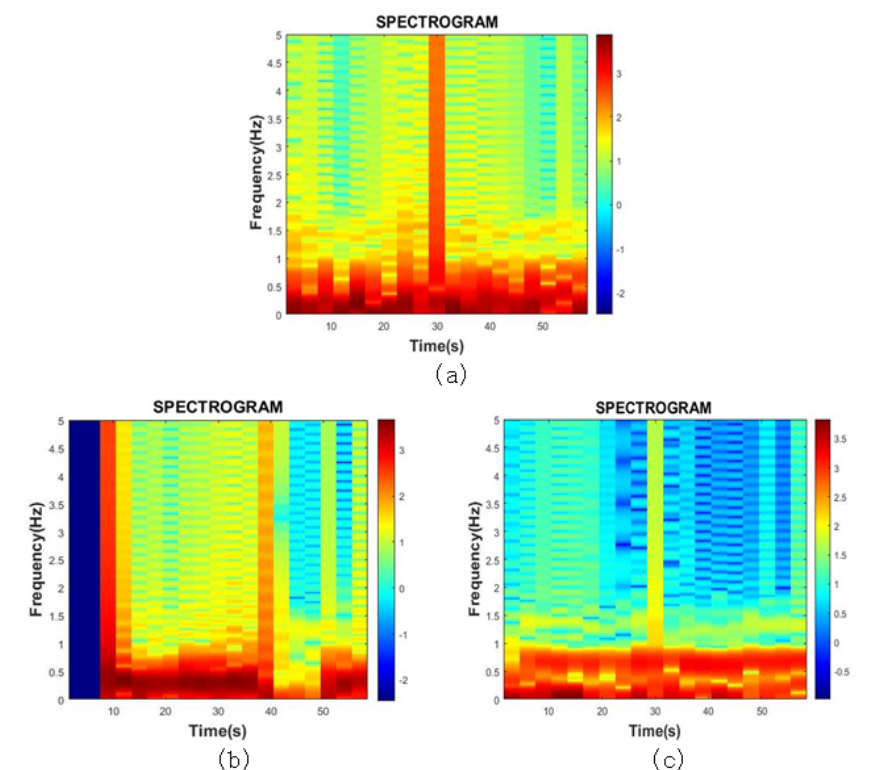
Figure 4. Spectrograms of three respiratory states: ( a ) Normal respiratory state ( b ) Abnormal (Apnea) state ( c ) Normal breathing during a speaking